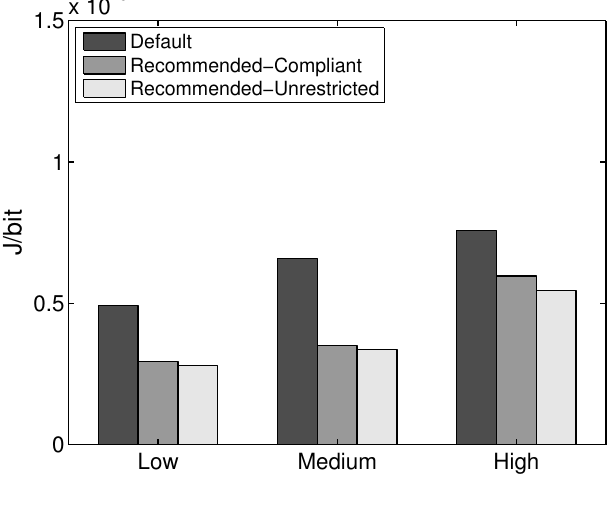
22. Comparison of average energy efficiency between default, Recommended-Compliant and Recommended-Unrestricted stack